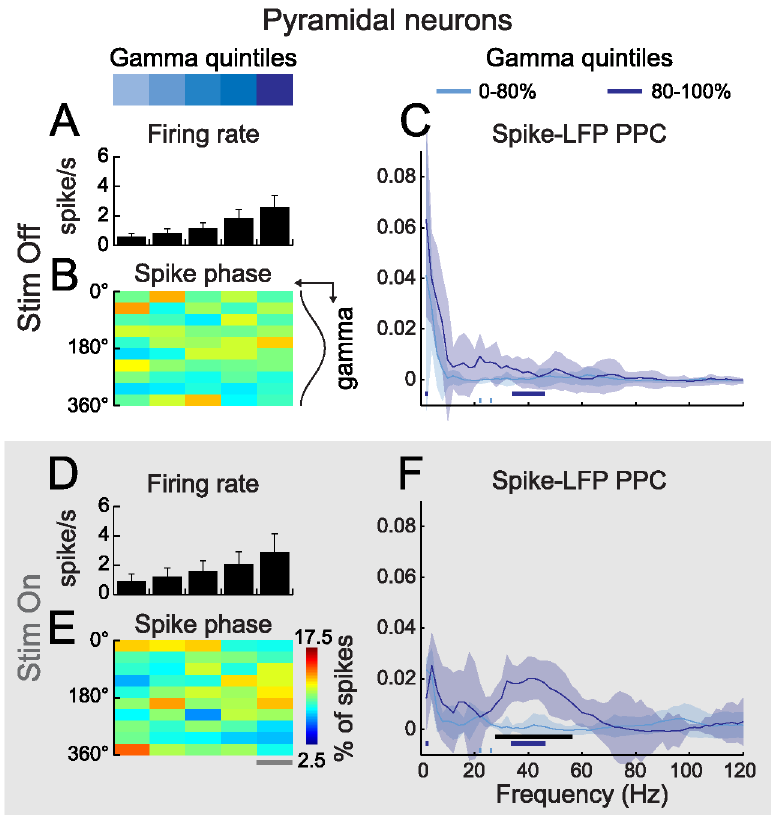
Fig 5. The firing of PYRs phase locks to strong gamma oscillations during visual stimulation. ( A, D ) Grand mean firing rate of PYRs, outside (A, Stim Off) and during (D, Stim On) visual stimulation, as a function of gamma quintile at spike time ( n = 10; error bars: s.e.m.). ( B, E ) PYR spikes occur preferentially before the trough of strong gamma oscillations during (E) but not outside (B) visual stimulation (color-code in (E): fraction of spikes falling in one of ten bins of gamma phase as a function of gamma quintile at spike time; gray line in (E): statistical difference from a uniform distribution, Rayleigh ’ s test, α = 10 − 5 ). ( C, F ) Strong gamma increases spike-LFP PPC in the gamma range (30 – 80 Hz) during visual stimulation (F) but not outside (C) ( n = 10; light and dark blue traces: pooled PPC respectively in the four weakest quintiles and in the strongest gamma quintile; shaded areas: +/- Jackknife 95% confidence interval; horizontal lines: statistical significance between the four weakest quintiles and the strongest gamma quintile [black] and between Stim Off and Stim On for the four weakest quintiles [light blue] and the strongest gamma quintile [dark blue], Materials and Methods).